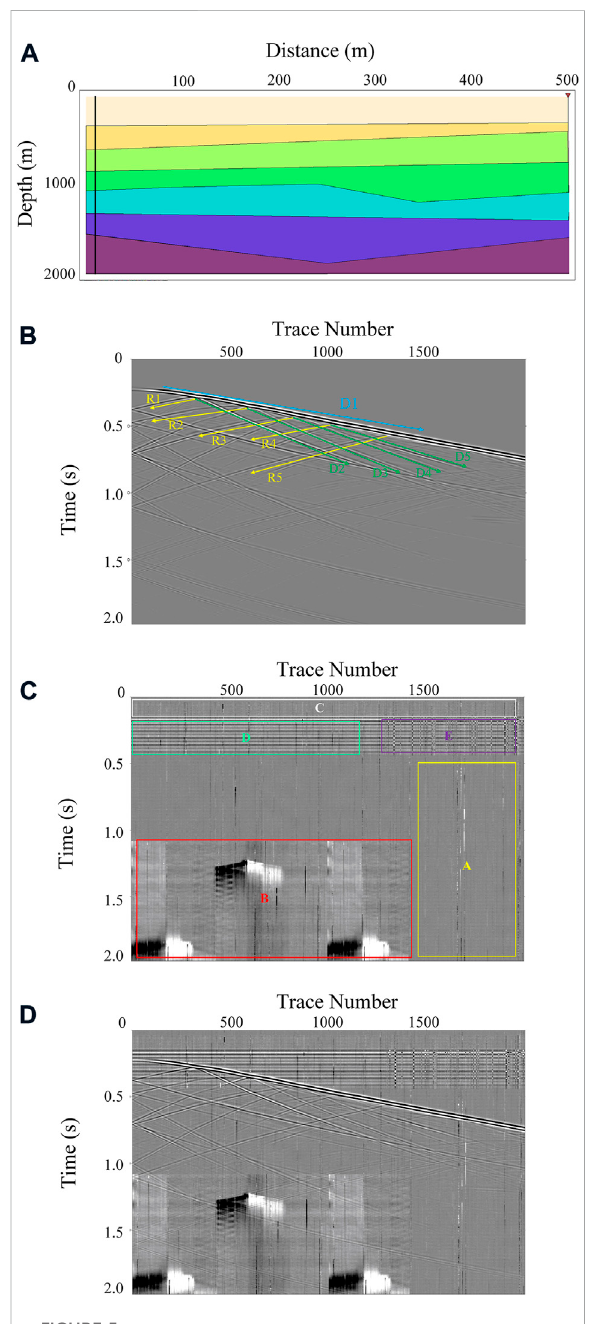
FIGURE 5 Construction of the noisy synthetic DAS-VSP record. (A) The velocity model. (B) The theoretical pure DAS-VSP record. (C) The added fi eld noise. (D) The synthetic noisy record with the SNR of -0.5132